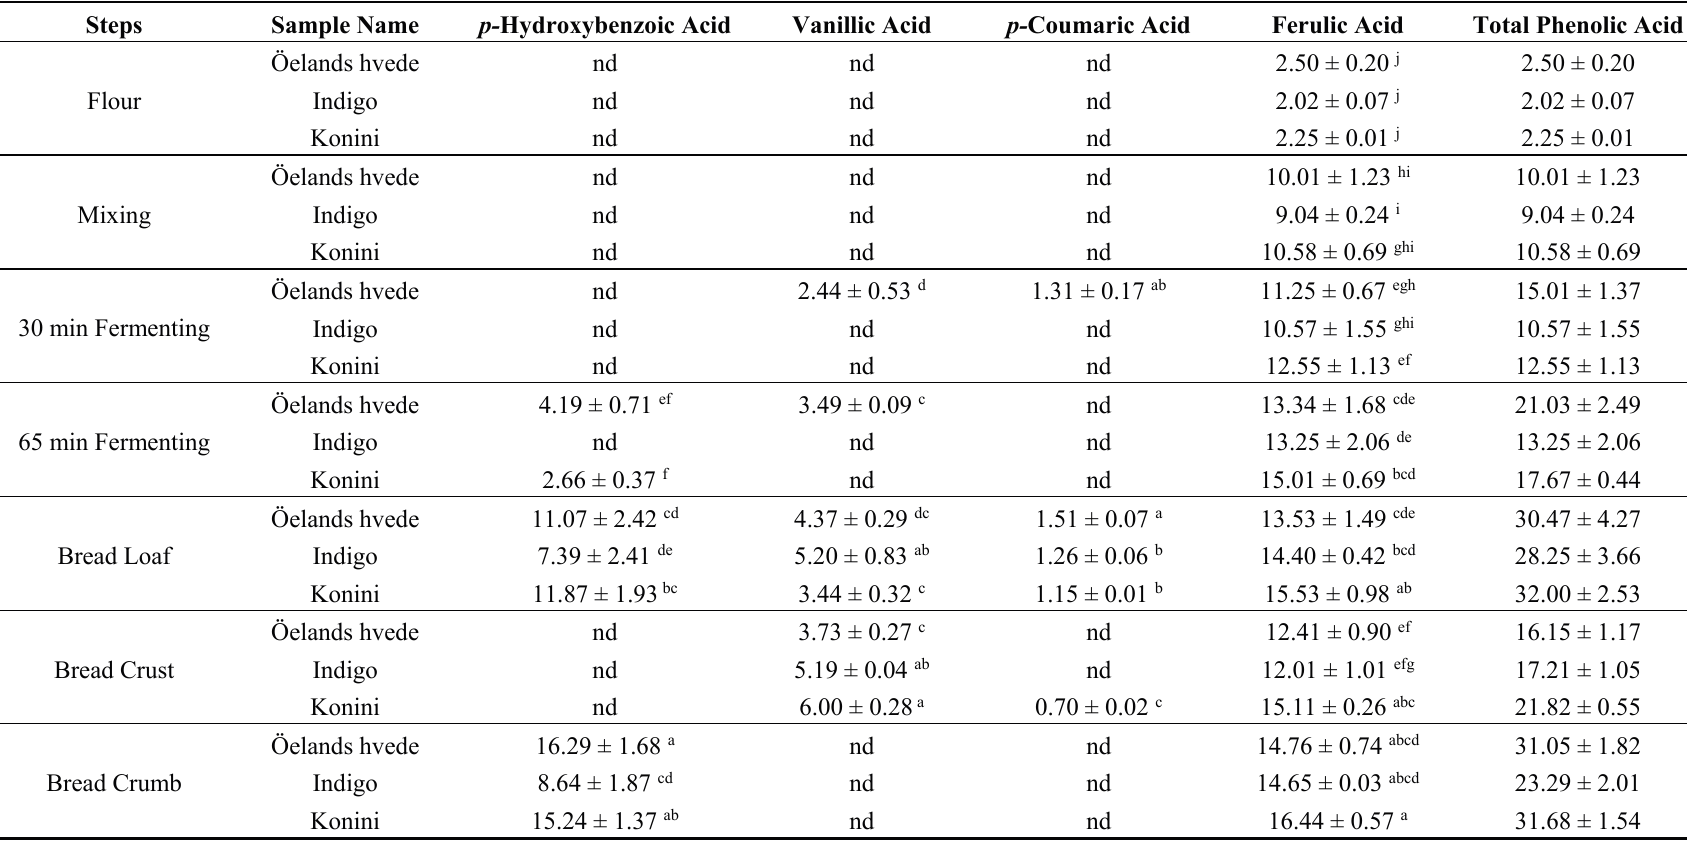
Table 2. Composition of soluble-free phenolic acids in normal and purple wheat grains at different stages of the bread-making process.